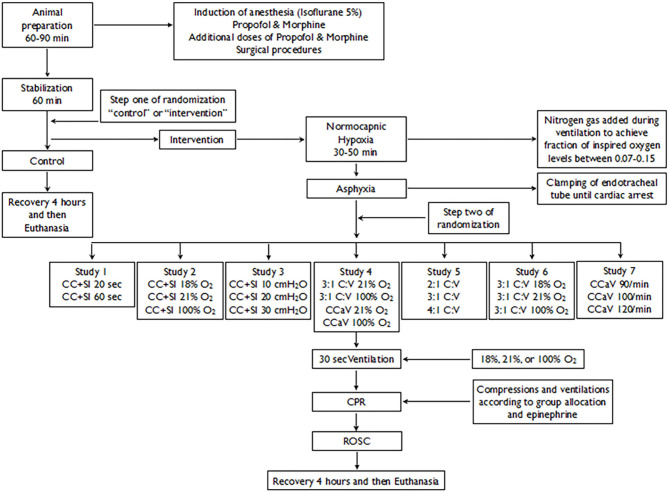
Study Flow Diagram.